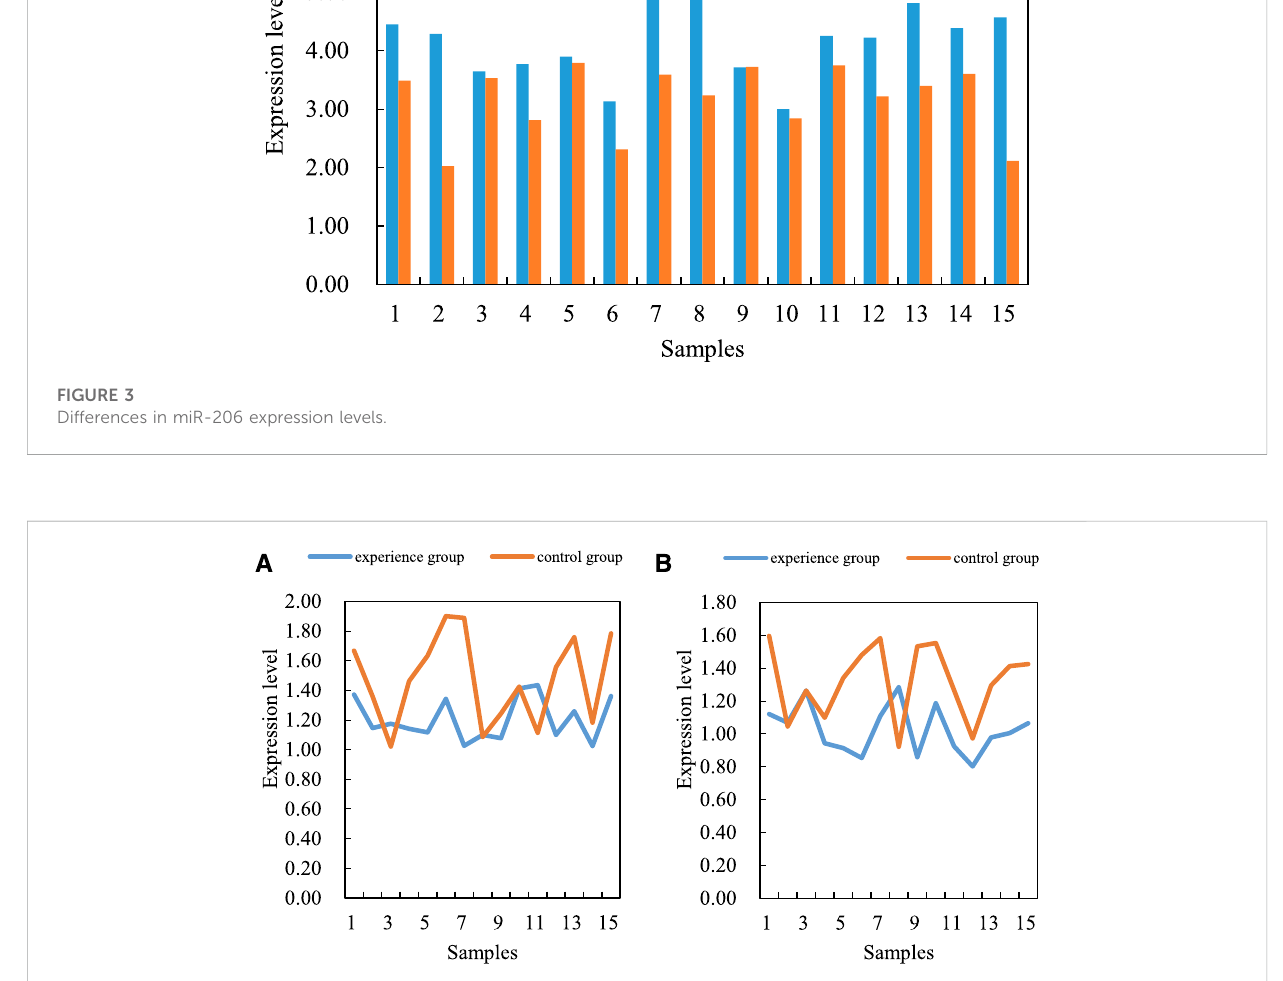
FIGURE 4 mRNA and protein levels of VEGF/PI3K/AKT signaling pathway. (A) MRNA (B)